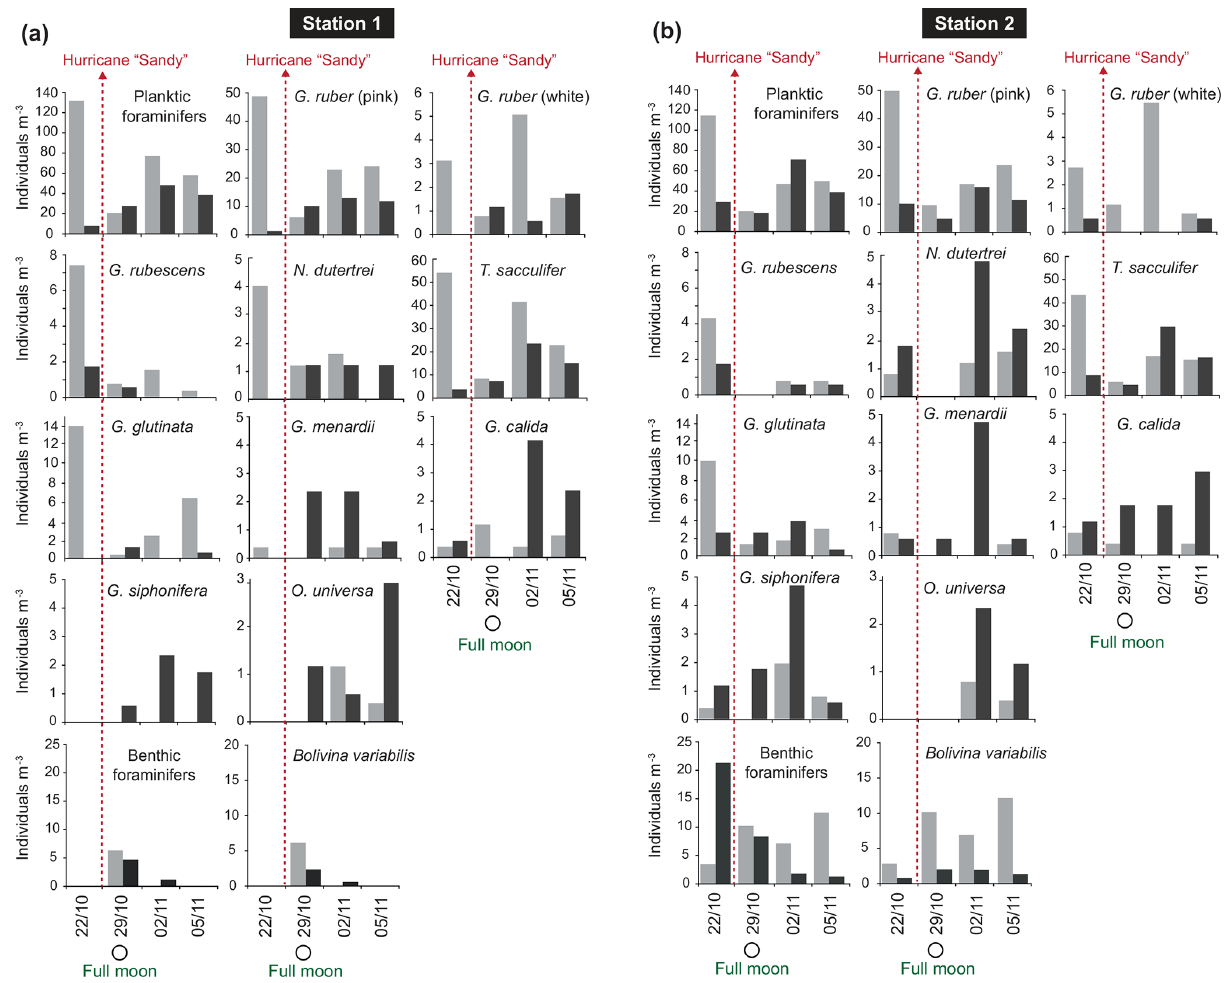
Figure 4. Foraminiferal abundance (individuals per m 3 seawater) at station 1 (a) and station 2 (b) of the upper (0–60m; light grey bars) and deeper (60–100m; dark grey bars) sampling intervals in 2012. Hurricane Sandy is marked by dashed red arrows.